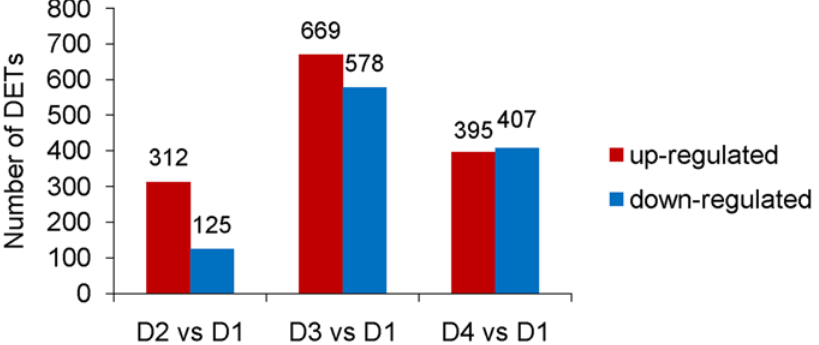
Fig 4. The up-regulated and down-regulated transcript numbers during drought